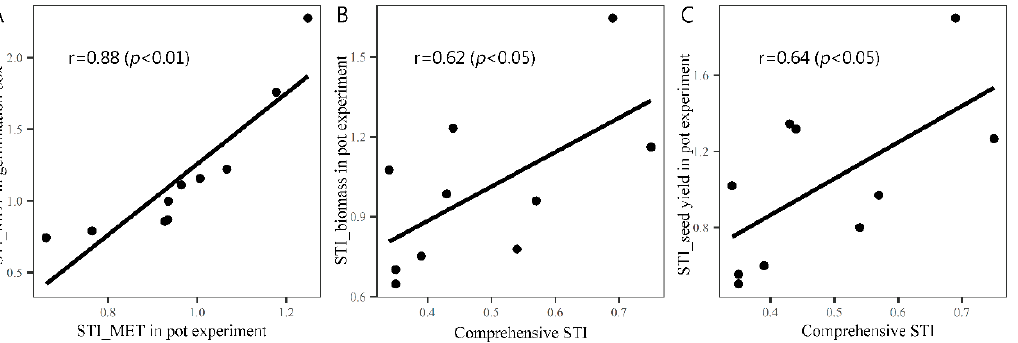
Figure 7. The agronomic performance under germination box trail and pot experiment of varieties with different low ‐ temperature tolerance comprehensive scores. ( A ) Comparison of low ‐ tempera ‐ ture STIs of seedling emergence between germination box and pot conditions; ( B ) relationship be ‐ tween comprehensive STIs in germination box and biomass ‐ related low ‐ temperature STIs in the pot experiment; ( C ) relationship between comprehensive STIs in germination box and seed yield ‐ re ‐ lated low ‐ temperature STIs in the pot experiment.